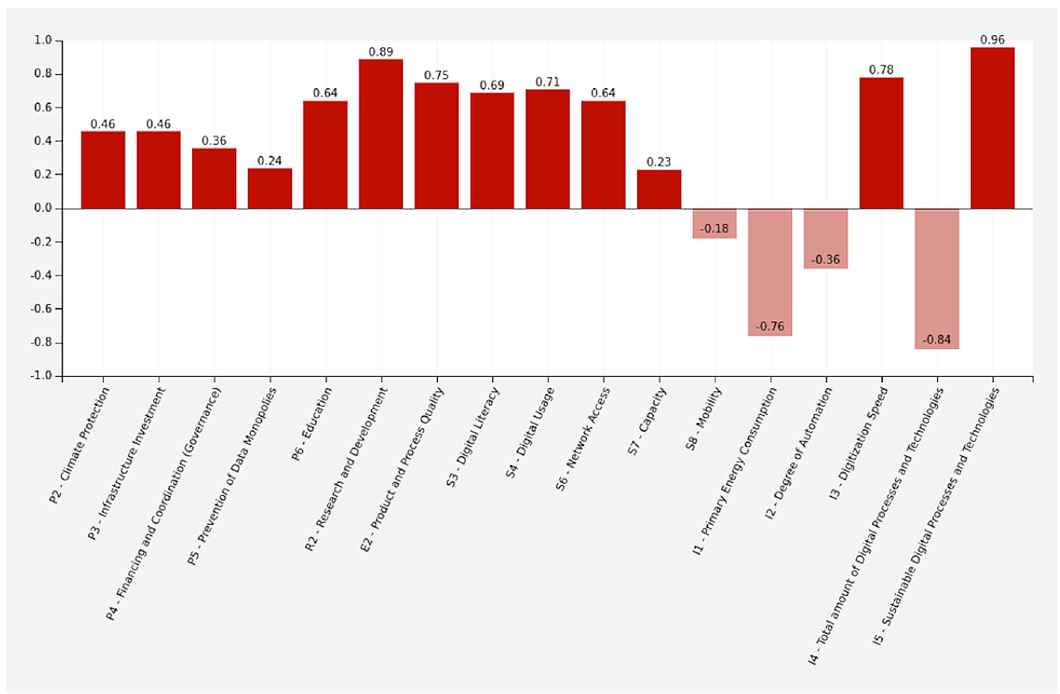
Figure 8. Simulation results. Innovative and sustainable COVID-19 scenario (Screenshot from Mental Modeler